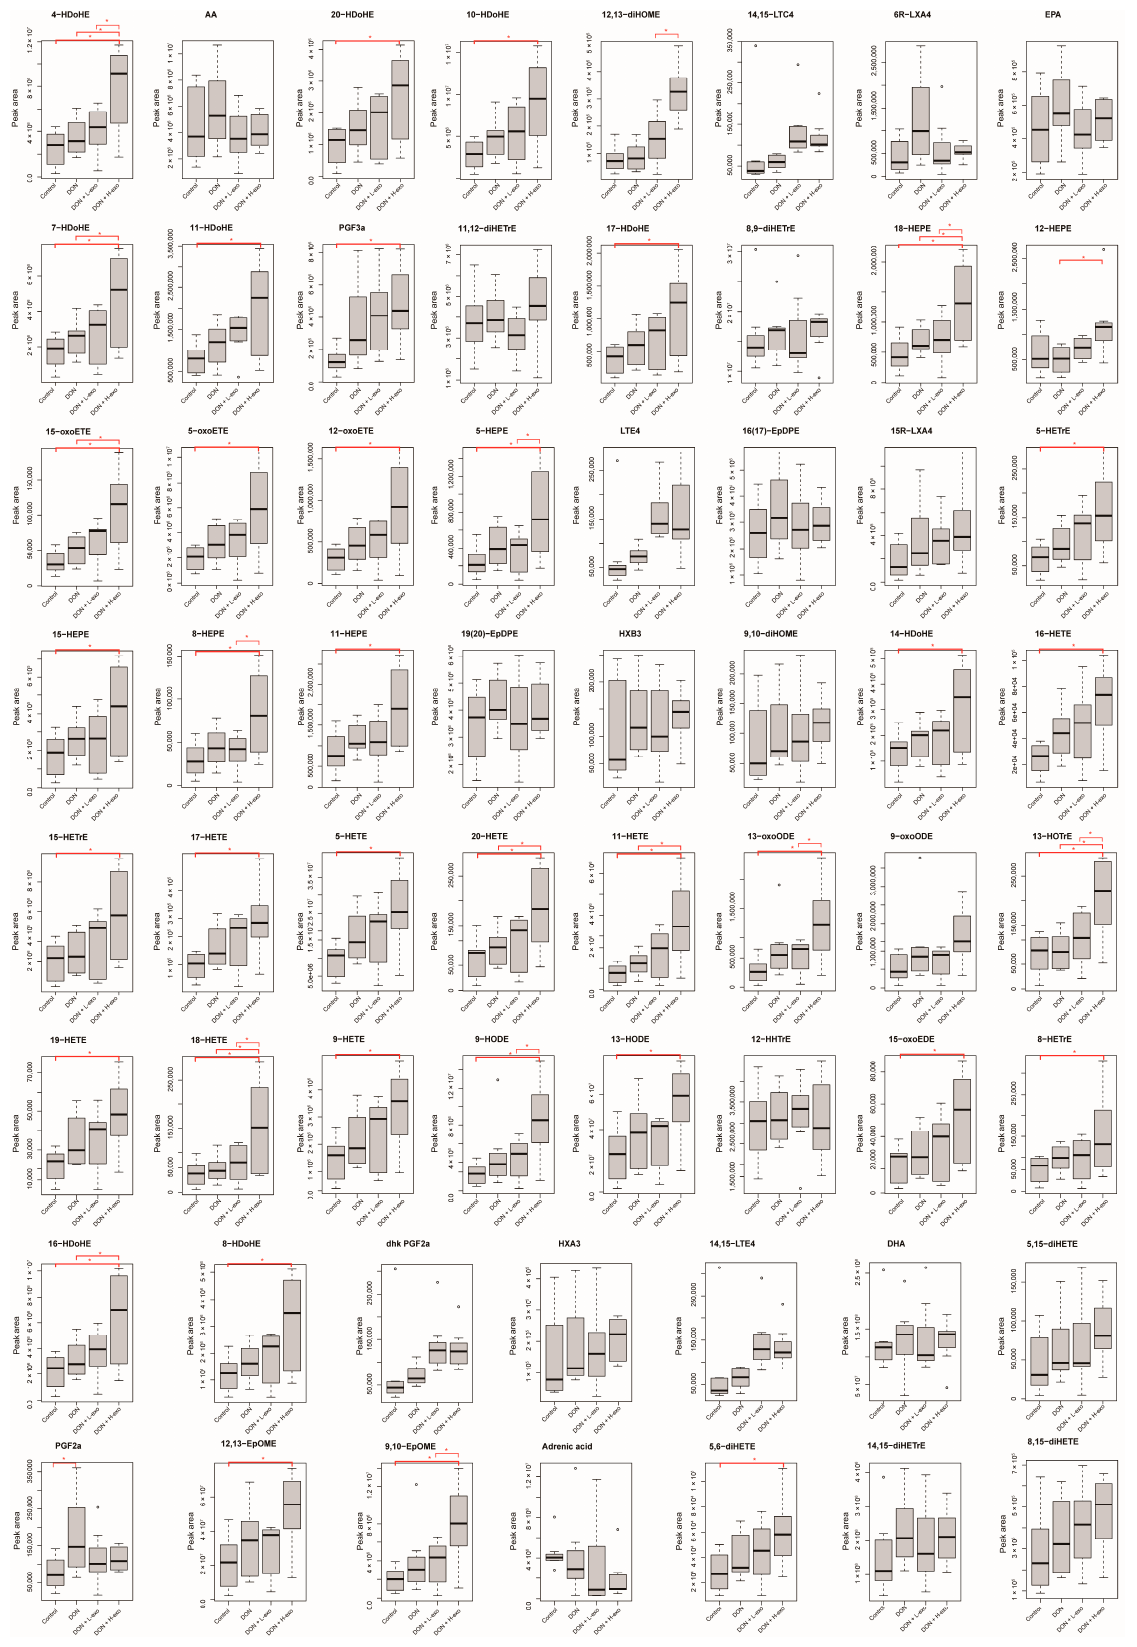
Figure 6. Boxplot of the relative content of all oxylipins detected in this study among the four groups. “*” means p <